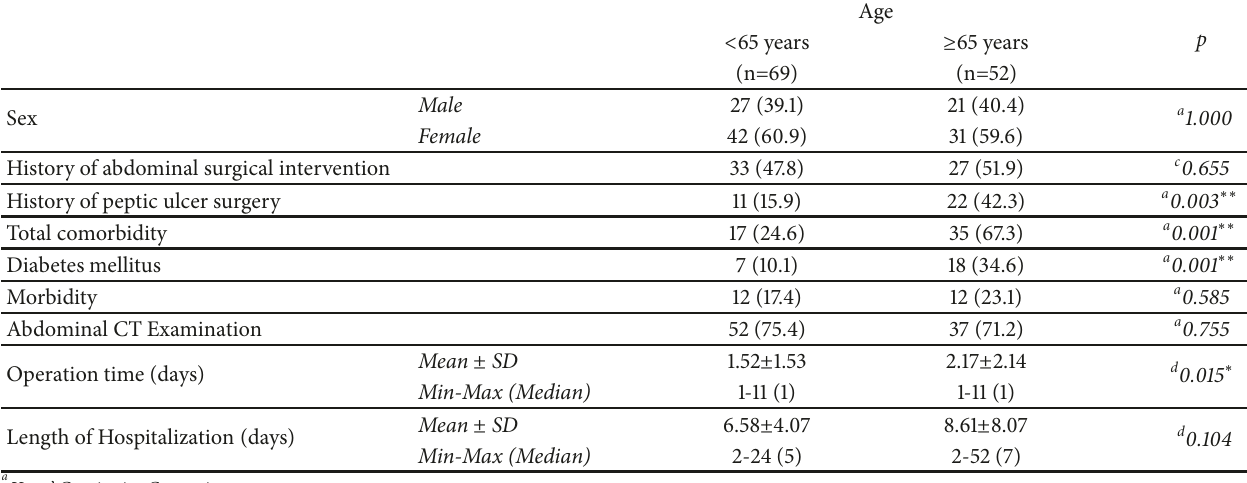
Table 3: Descriptive and comparative properties according to age.